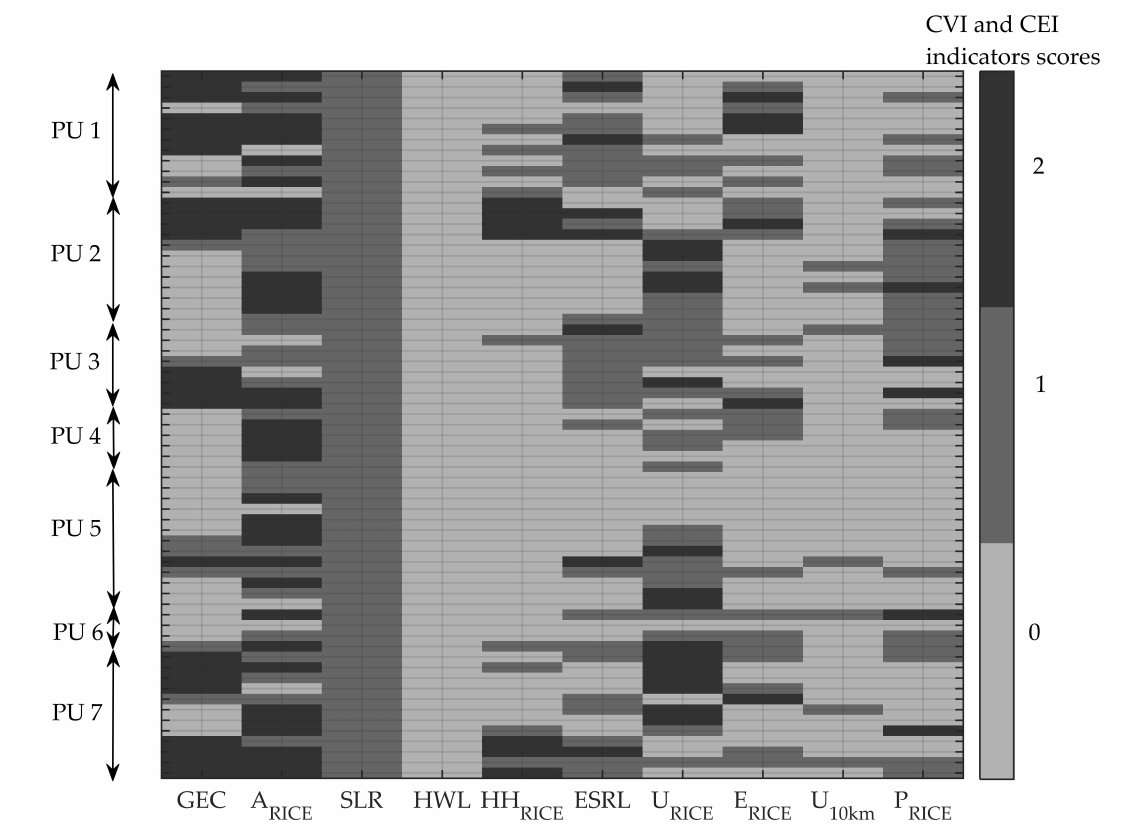
Figure 4. Scores calculated for CVI and CEI indicators in all